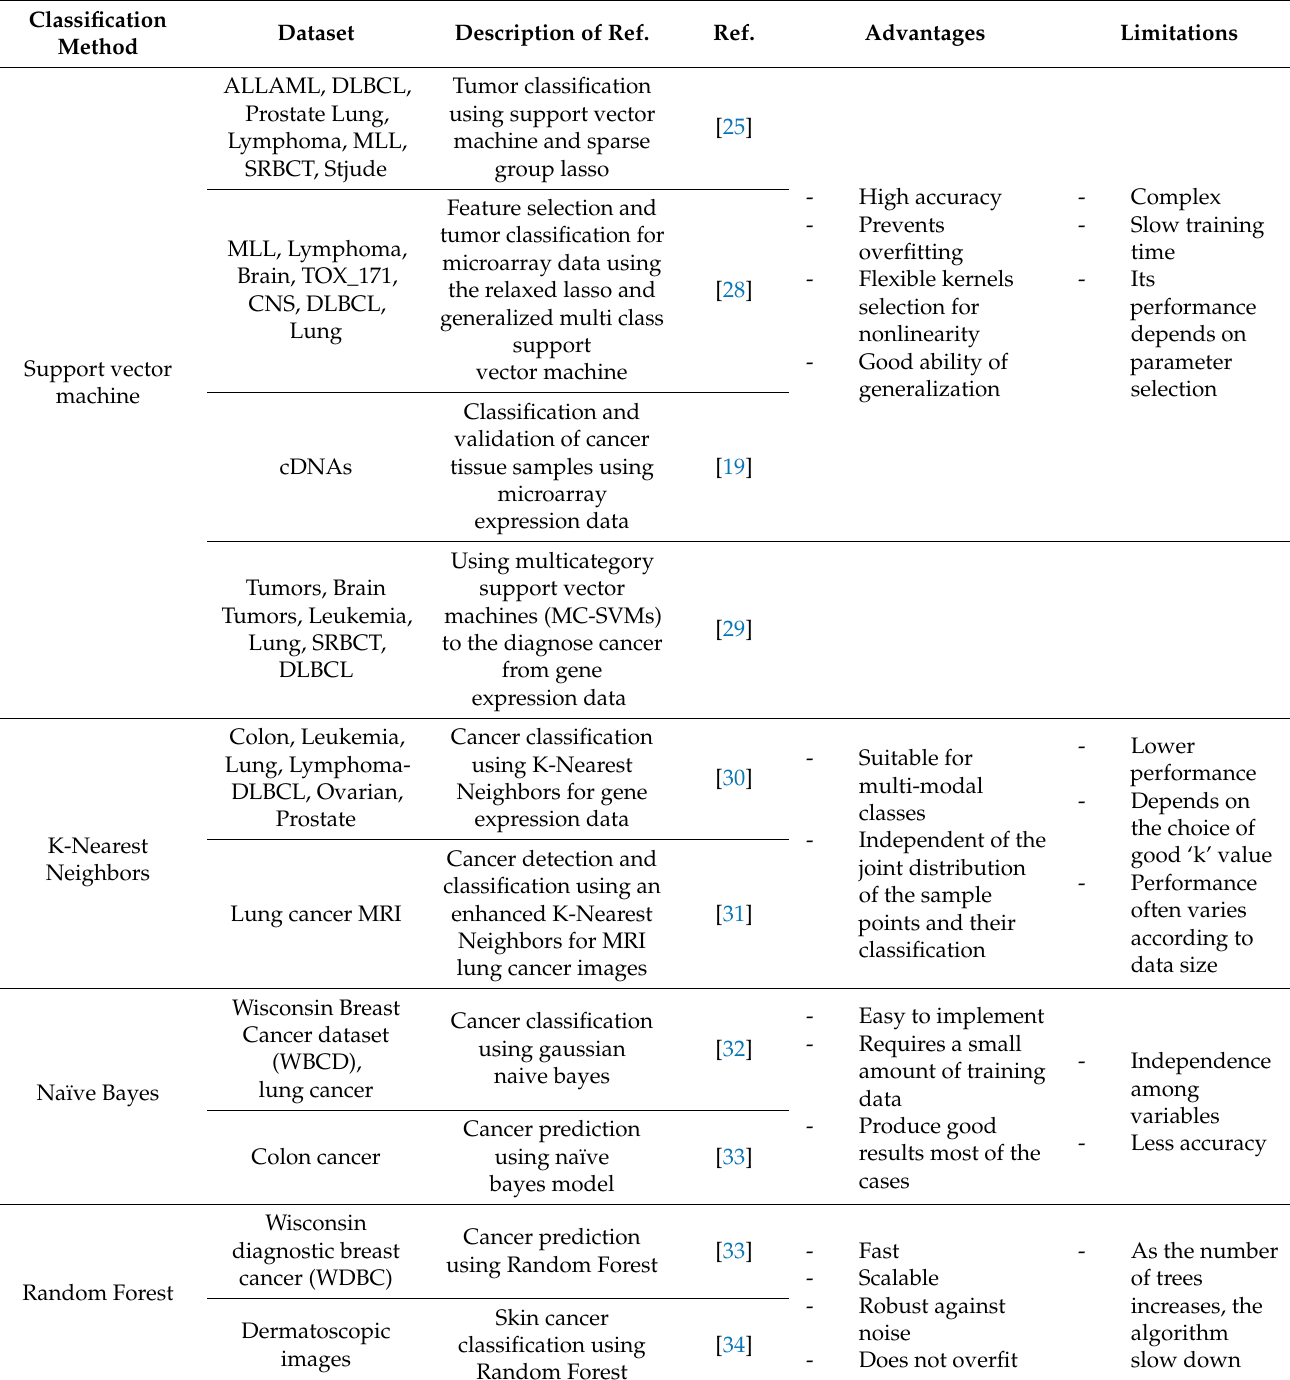
Table 1. Supervised Machine Learning